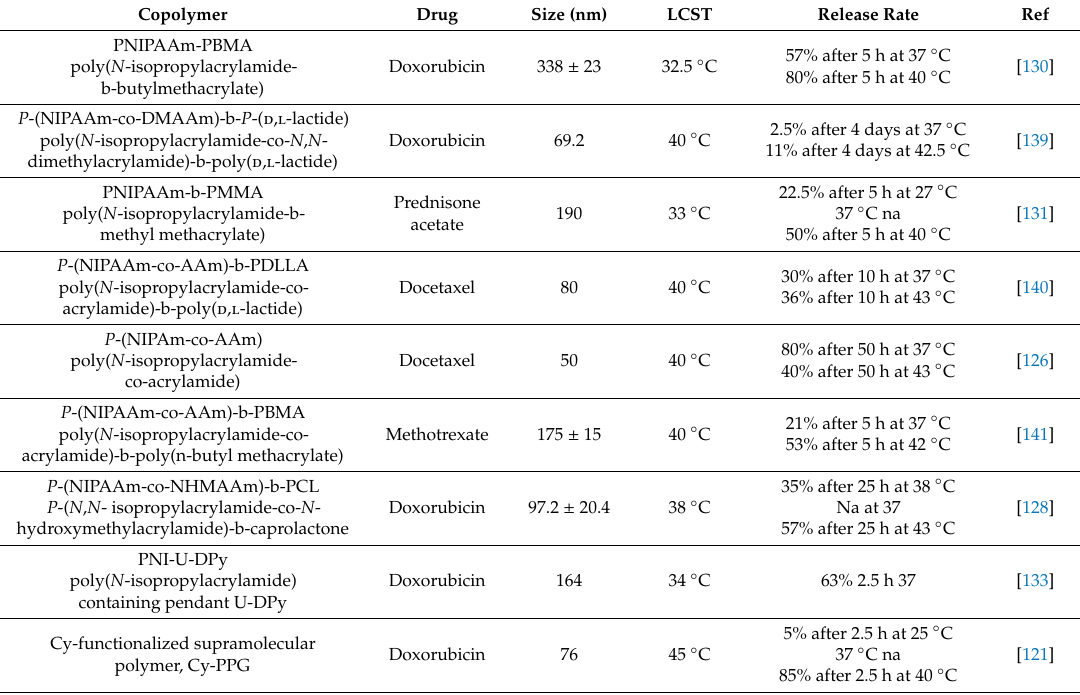
Table 1. Temperature sensitive polymeric nanoparticles fabricated with polymers exhibiting lower critical solution temperature